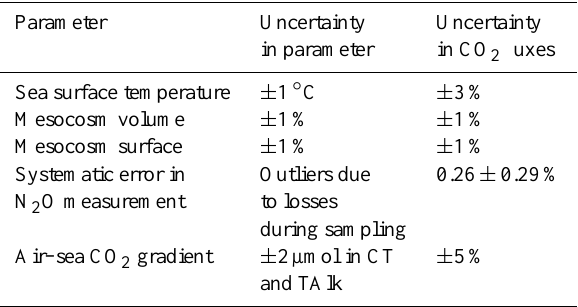
Table 1. Sensitivities of the overall resulting CO 2 fluxes to uncer- tainties in the determination of the most important measured vari- ables of the presented method. The effect of systematic N 2 O un- derestimation was tested using an alternative fit including only up- per end values from the Svalbard dataset. The influence of errors in CO 2 gradient determination is denoted for an intermediate gradient of